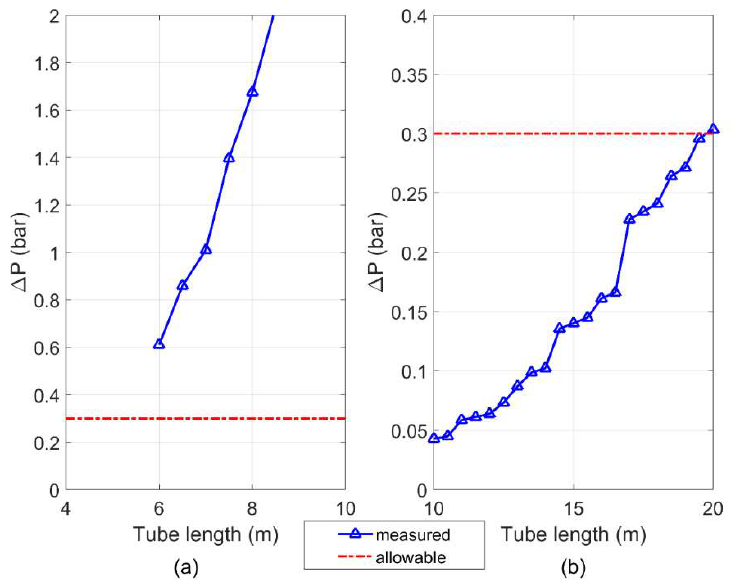
Figure 8. Refrigerant pressure drop vs. length of the tube for 4 rows ( a ) outside diameter of 7.35 mm; and ( b ) outside diameter of 18.5 mm.